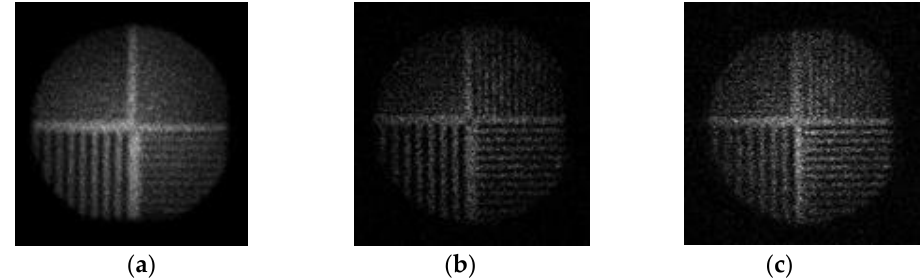
Figure 10. Sensitivity efficiency and SNR improvement-same scan time: ( a ) single pinhole—4.45 mm diameter, low resolution; ( b ) Single pinhole—2 mm diameter, low sensitivity efficiency; ( c ) multipinhole array—2 mm diameter, high resolution and sensitivity efficiency.